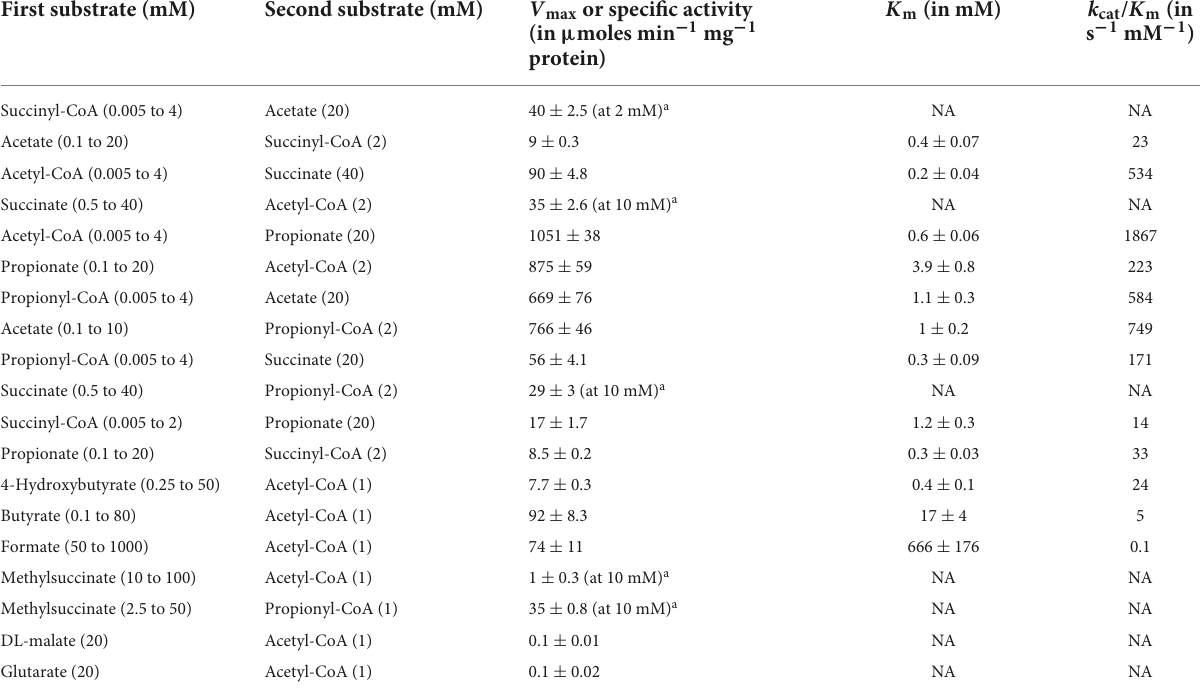
TABLE 2 Catalytic properties of the heterologously produced succinyl-CoA:acetate CoA-transferase encoded by the AHF96498 gene. First substrate